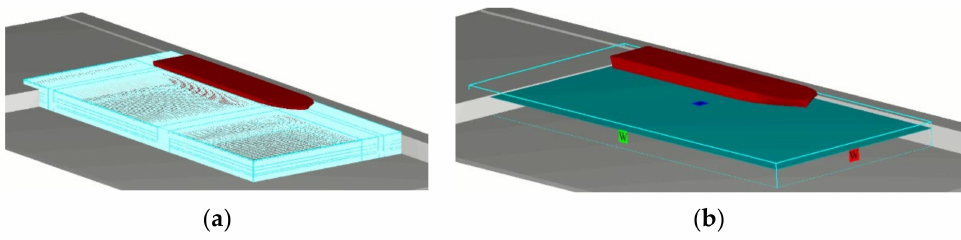
Figure 3. Computing domain: ( a ) computing domain with the overlapping meshes; ( b ) boundary conditions applied for the bow thruster-generated flow field